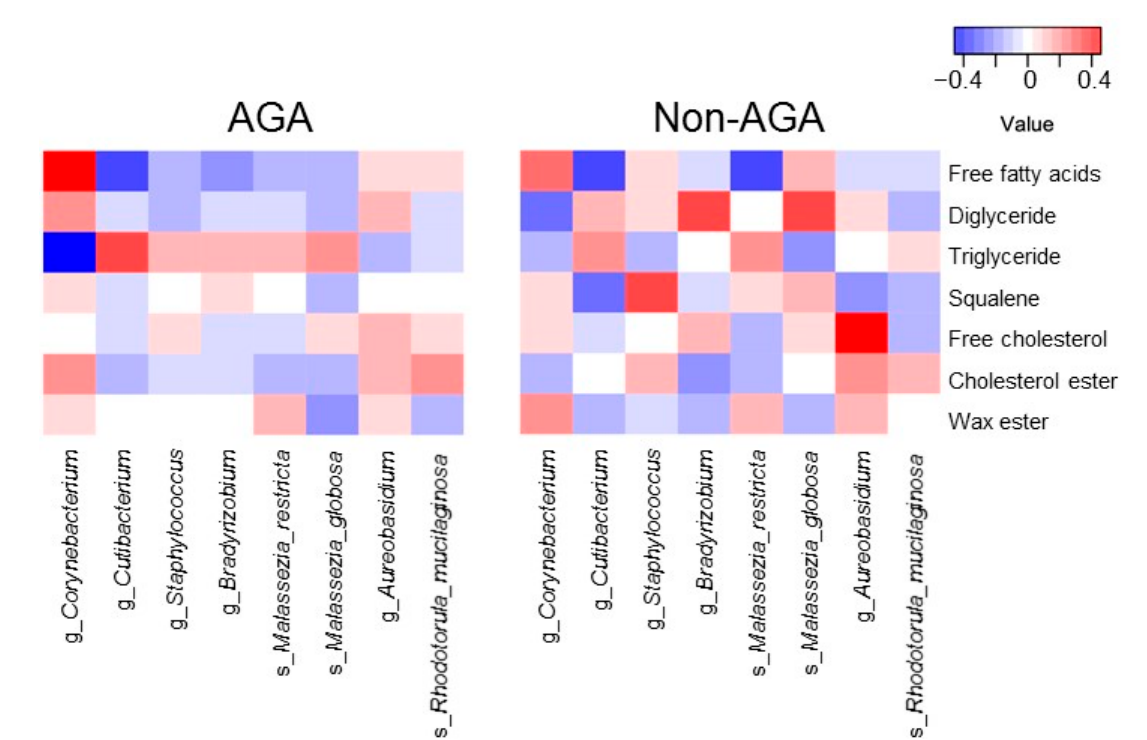
Figure 5. Heatmap of the predominant scalp microbiota and sebum composition.